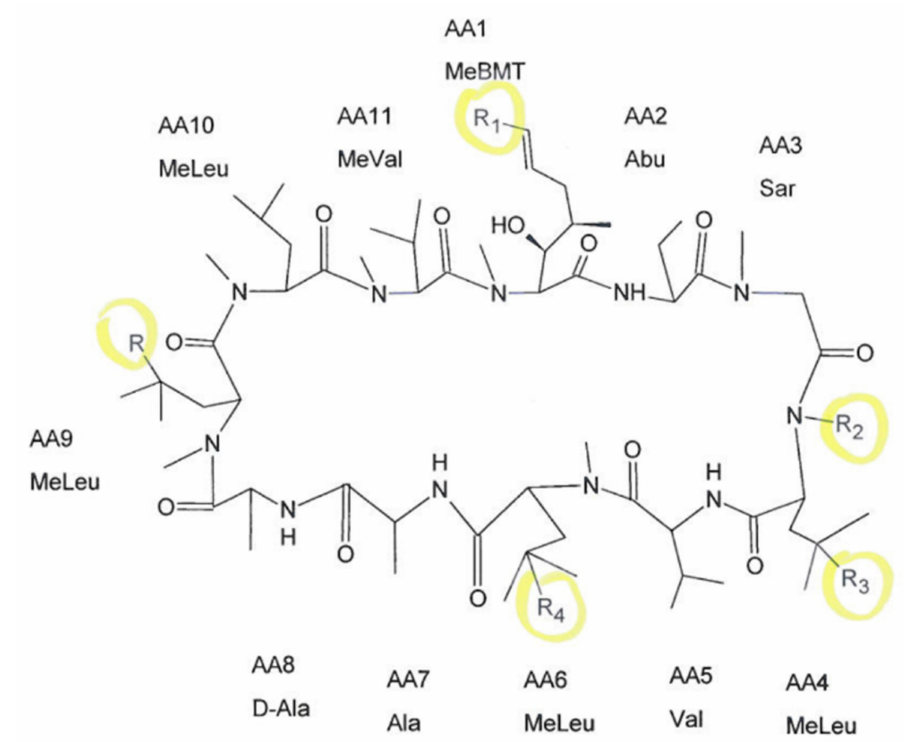
Figure 1. The chemical formula of cyclosporine A (CsA) with marked positions of potential metabolic